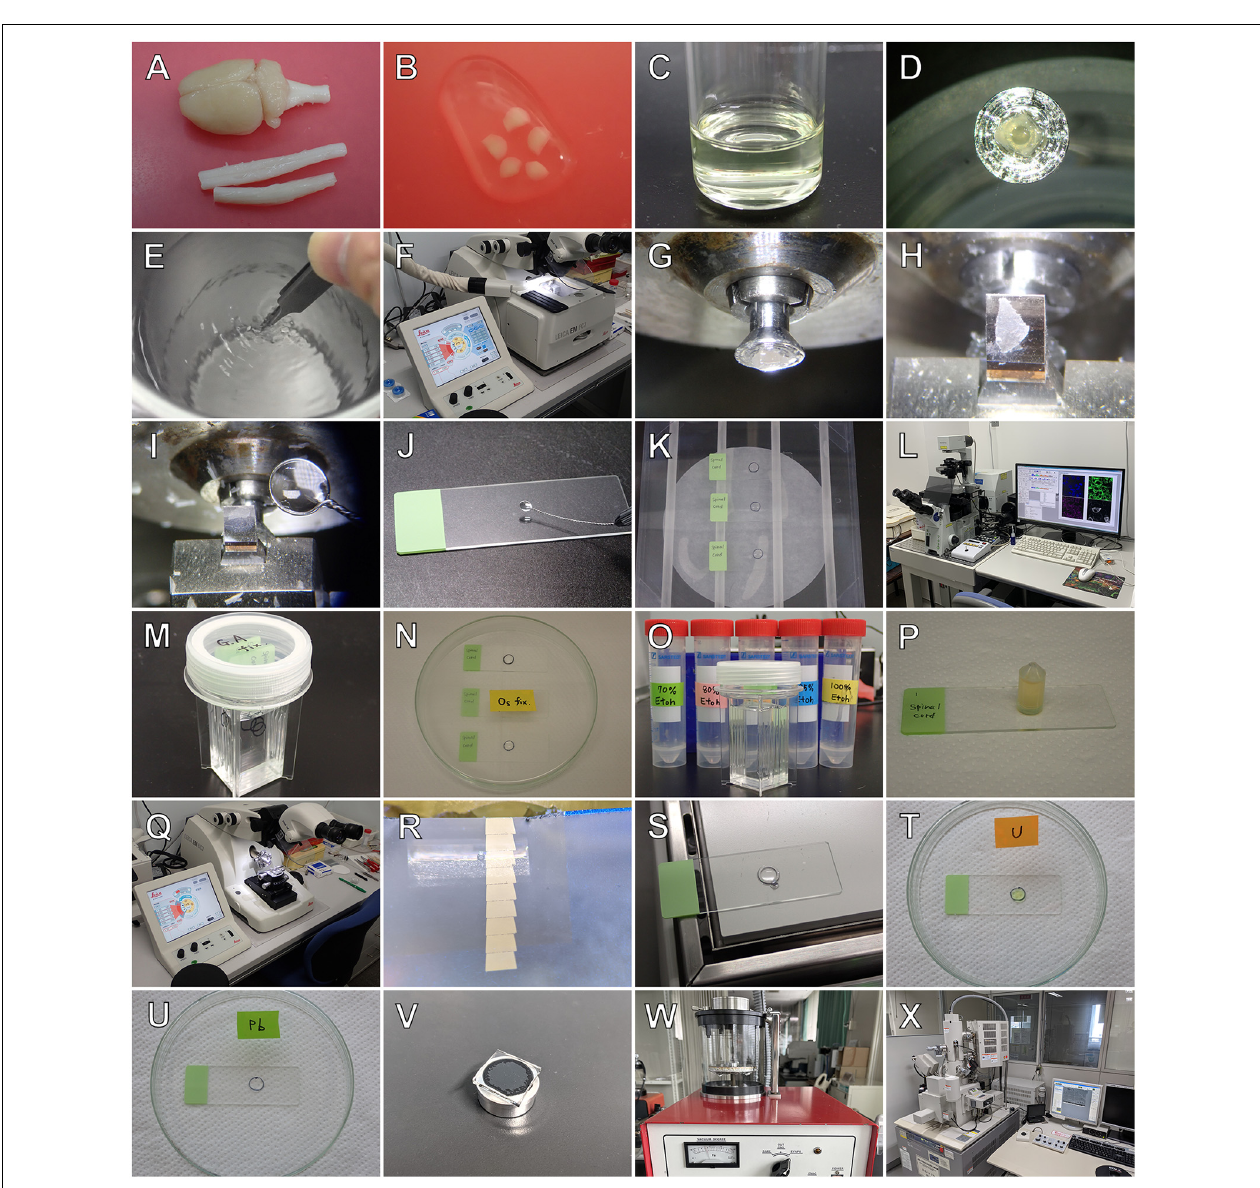
FIGURE 3 | Outline of the combination of the Tokuyasu cryo-sectioning method with section-face imaging. After perfusion fixation, tissues are removed from animals (A) , cut into small pieces (B) , and immersed in cryoprotectant materials (C) . The specimens are then mounted on sample holders (D) , rapidly frozen in liquid nitrogen (E) , and placed into a cryo-chamber attached to an ultramicrotome (EM FC-7; Leica, F,G ). Semithin cryosections of tissues are cut using a diamond knife (Diatome) (H) in a low-temperature sectioning system. The cryosections are picked up with a 2.3 M sucrose droplet on a wire loop (I) and mounted on glass microscope slides for subsequent immunocytochemistry (J) . After immunocytochemical staining (K) , regions of interest of the cryosections are photographed with a confocal laser scanning microscope (FV1000-D; Olympus) (L) . The cryosections are then further fixed with glutaraldehyde (M) and osmium tetroxide (N) , dehydrated with a graded series of ethanol (O) , and embedded in epoxy resin (P) . Ultrathin sections are cut from the resin-embedded semithin cryosections with an ultramicrotome (Q) using a diamond knife (Diatome) (R) , mounted onto glass slides (S) , stained using heavy metals of uranyl acetate (T) and lead citrate (U) , mounted onto aluminum stubs (V) and coated with carbon in a carbon coater (VC-100S; Vacuum Device) (W) . The same area imaged previously using laser microscopy is observed using backscattered electron-mode scanning electron microscopy (SU70; Hitachi) (X)